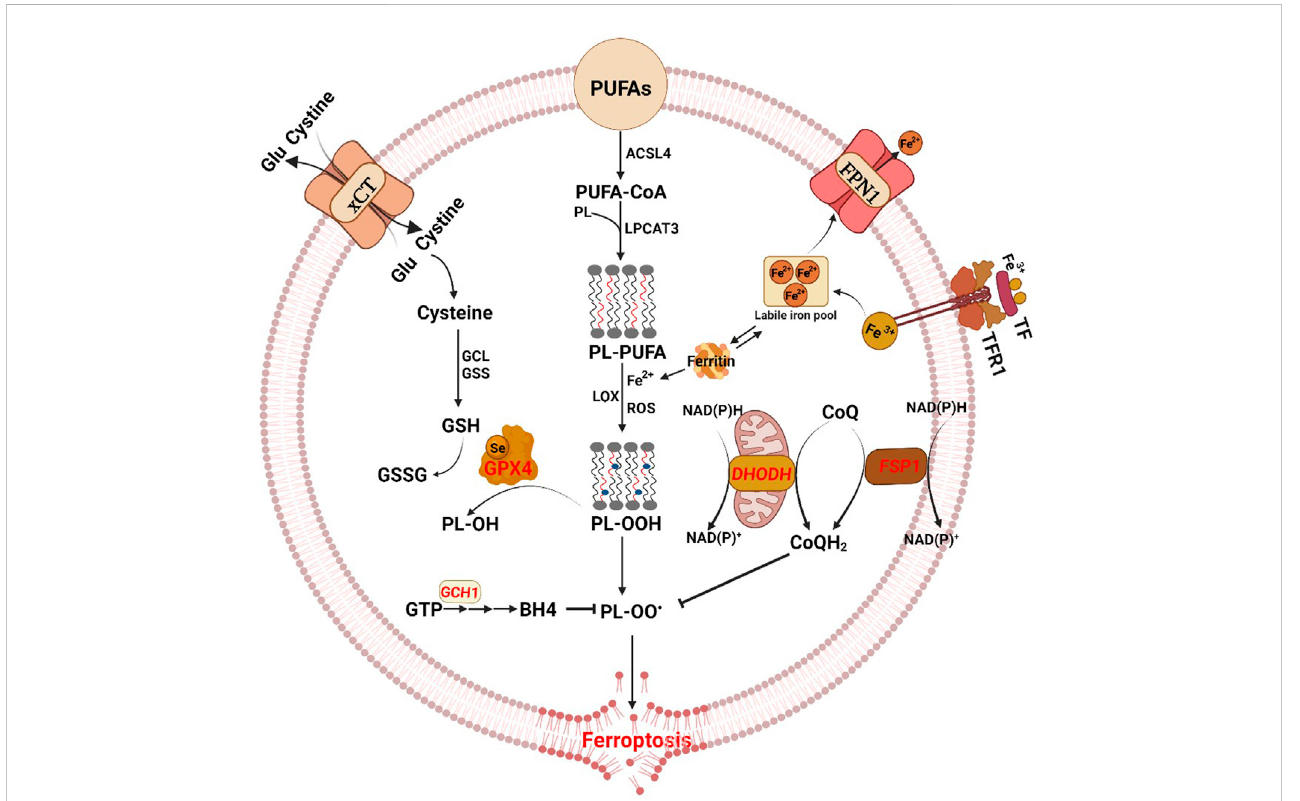
FIGURE 1 Theantioxidant pathwaysofferroptosis.The diagramshowsthecoreprocessofferroptosisandkeymolecules. Ferroptosis ischaracterizedbyironload, excessivereactiveoxygenspecies(ROS)productionandlipidperoxidationaccumulation.Thethreemainregulatorymechanismsofferroptosis,withdifferent subcellular localization, include the cytoplasmic cyst(e)ine/GSH/GPX4 pathway, the cell membrane-associated FSP1 – CoQ-NAD(P)H pathway, and the mitochondrialDHODH – CoQ-NAD(P)Hpathway.Moreover,thereareadditionalregulatorsofferroptosis.Gluglutamate,GCLglutamate-cysteineligase, GSSglutathionesynthetase,GSHglutathione,GSSGoxidizedglutathione,GPX4glutathioneperoxidase4,PUFAspolyunsaturatedfattyacids,ACSL4acyl-CoA synthetase long-chain family member 4, PL phospholipid, LPCAT3 lysophosphatidylcholine acyltransferase 3, LOX lipoxygenase, FSP1 ferroptosis suppressor protein 1, DHODH dihydroorotate dehydrogenase, TF transferrin, TFR1 transferrin receptor protein-1, FPN1 ferroportin 1, GTP guanosine triphosphate, GCH1 GTP cyclohydrolase 1, BH4